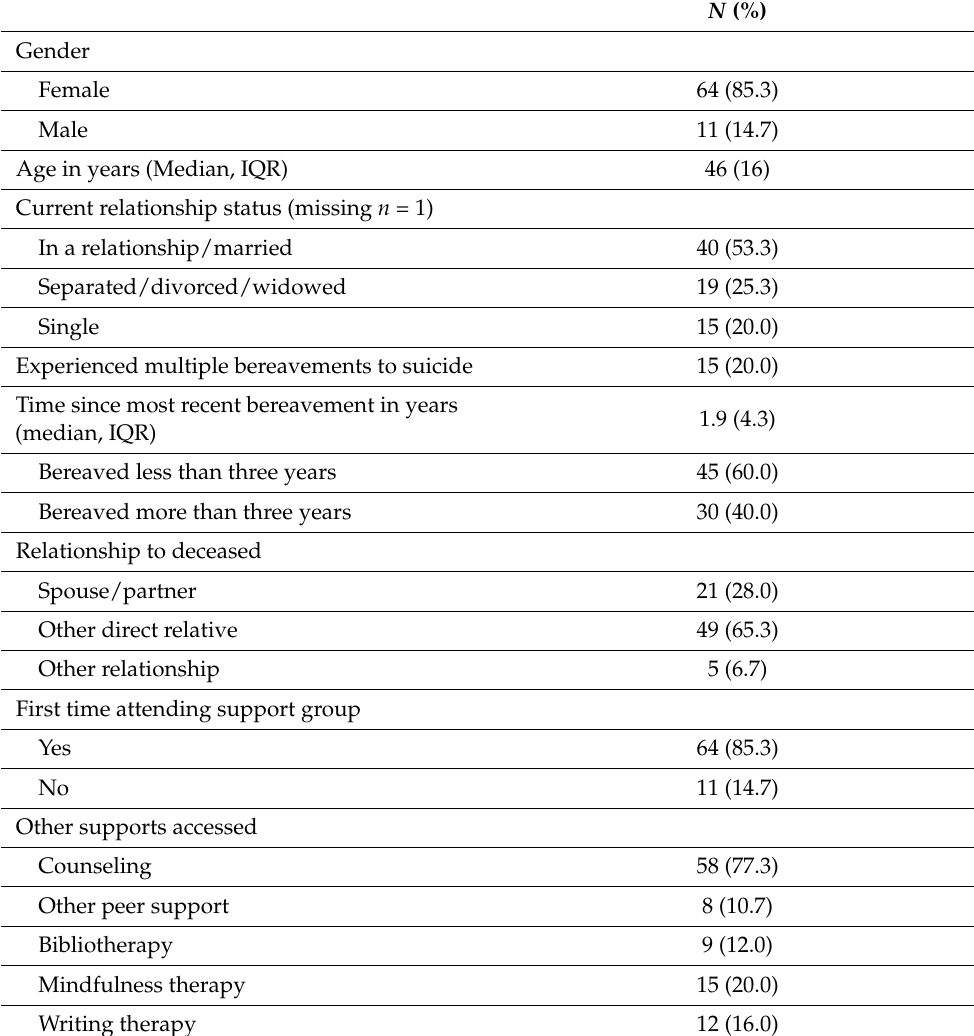
Table 1. Demographics of survey respondents ( n =